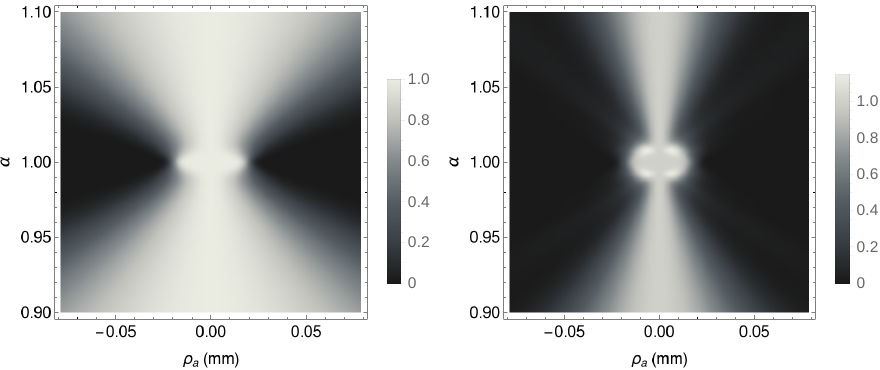
Figure 4. Comparison between the coherent and the incoherent ghost image of a single slit of width a = 26 µ m, as given by Equations (12) and (13), respectively, in the same setup described in Section 3. Both functions have been normalized to their value in ρ a = 0 for any value of α